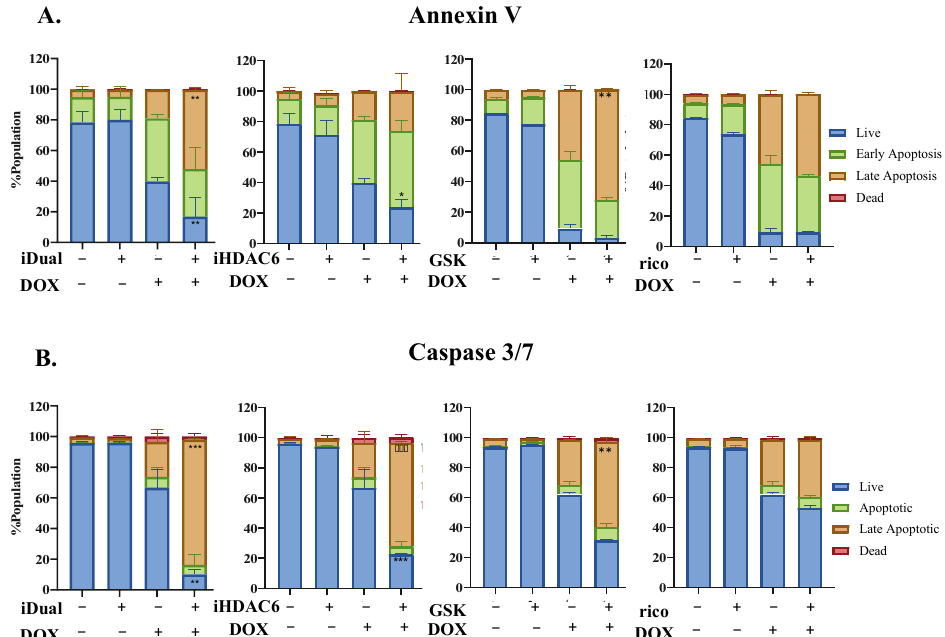
Figure 6. Flow cytometric analysis of doxorubicin combination in THP ‐ 1 cells. Apoptosis levels of THP ‐ 1 cells pretreated with iDual, iHDAC6 or GSK2879552 (5 μ M, 72 h) or ricolinostat (1.25 μ M, 72 h) followed by co ‐ treatment with doxorubicin (62.5 nM, 48 h). ( A ) Annexin V or ( B ) caspase 3/7 and 7 ‐ AAD positive cells were analyzed by flow cytometry (Figures S23 and S24). Data were represented as the average of ± standard deviation from two biological repeats (* p < 0.05, ** p < 0.01 and *** p < 0.001, two ‐ way ANOVA).